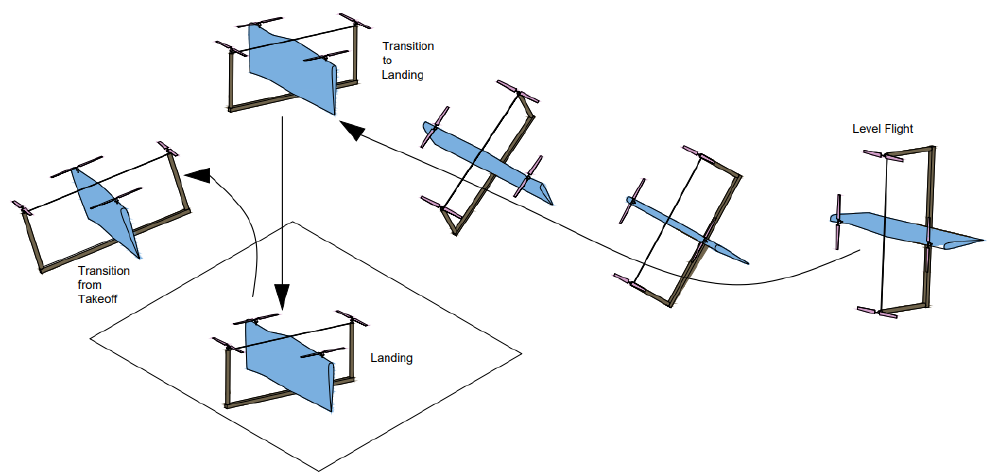
Figure 2. Takeoff and landing of tail-sitter quadrotor